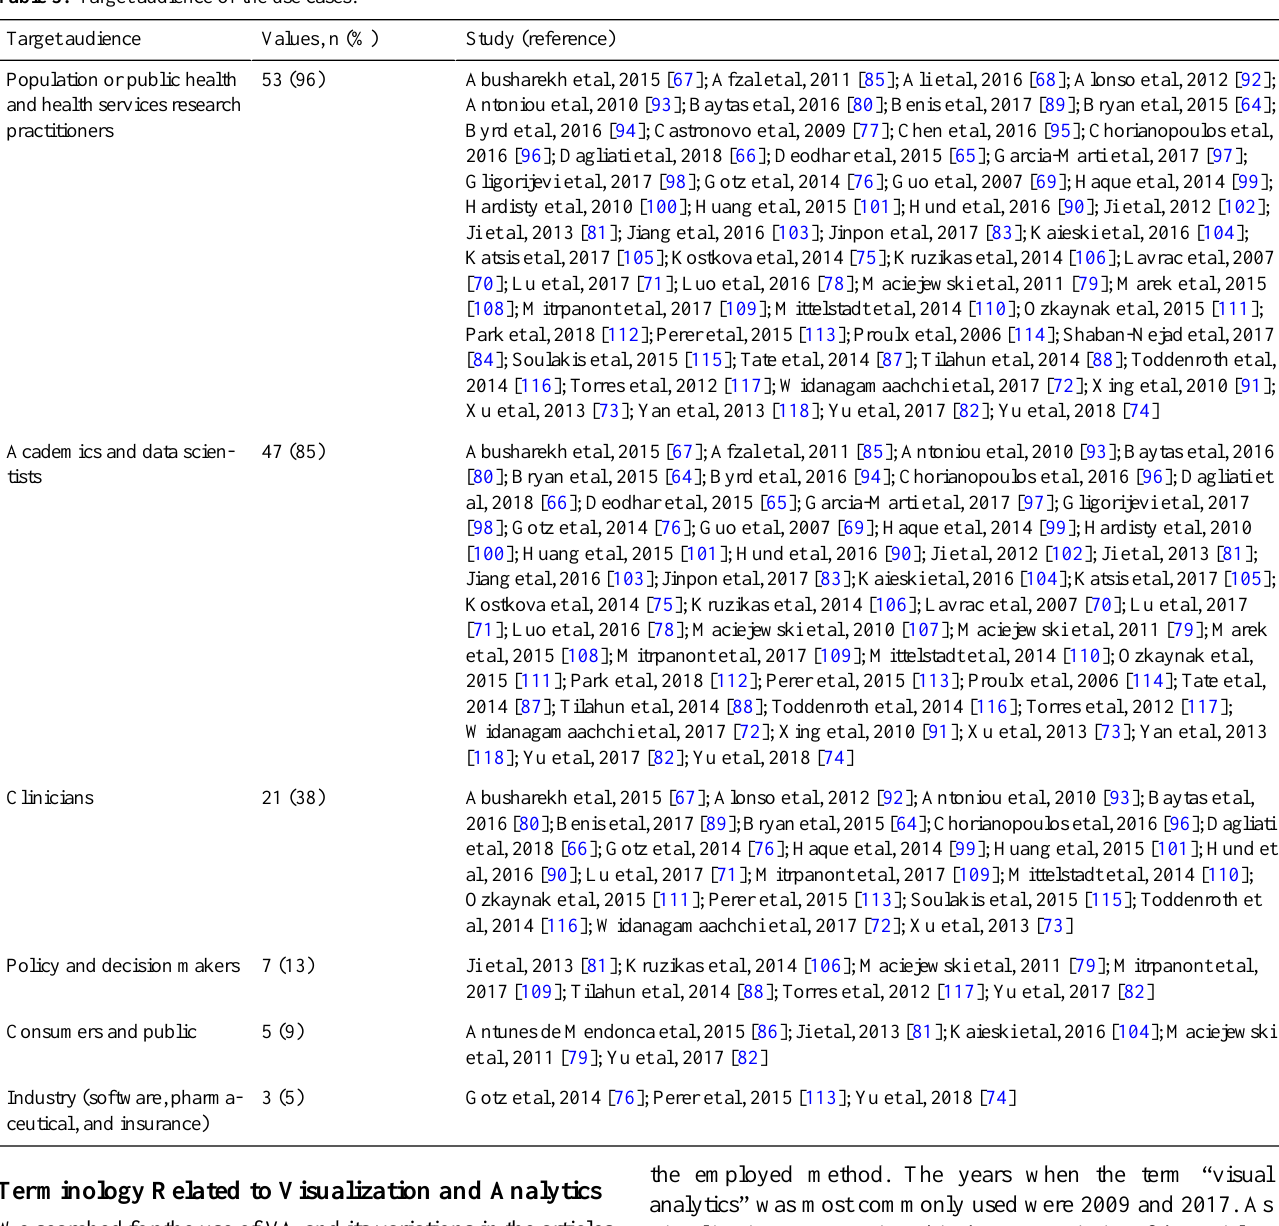
Table 3. Target audience of the use cases.